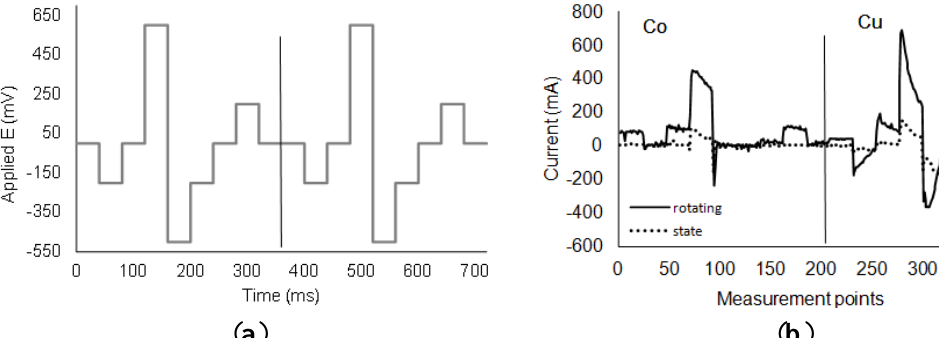
Figure 3. ( a ) Applied pulse sequence and ( b ) obtained response from glyphosate aqueous solutions (C = 5 × 10 −3 mol·dm −3 ) using the Co and Cu electrodes (dashed line) and when the electrodes were rotating (continuous line) after subtracting the solvent